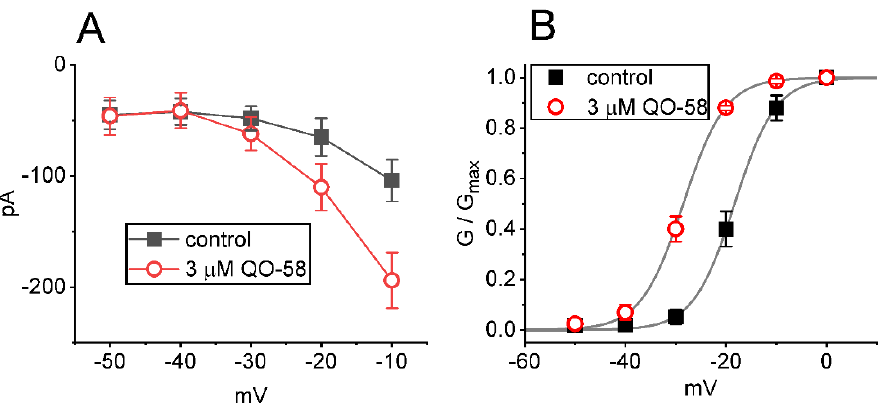
Figure 2. Effect of QO-58 on the current versus voltage ( I-V ) relationship ( A ) and the activation curve ( B ) of I K(M) . The experimental protocol applied is the same as that used in Figure 1. ( A ) Average I-V relationship of I K(M) amplitude acquired in the control period (i.e., absence of QO-58, solid black squares) and during cell exposure to 3 μM QO-58 (open red circles). ( B ) Steady-state activation curve of I K(M) in the absence (solid black squares) and presence (open red circles) of 3 μM QO-58 (mean ± SEM; n = 8). Smooth curves drawn were optimally fitted to a modified Boltzmann function as elaborated in Section 4. Of note, there is a leftward shift along the voltage axis in the quasi-steady-state activation curve of I K(M) in QO-58 presence, despite being void of changes in the gating charge of the curve.